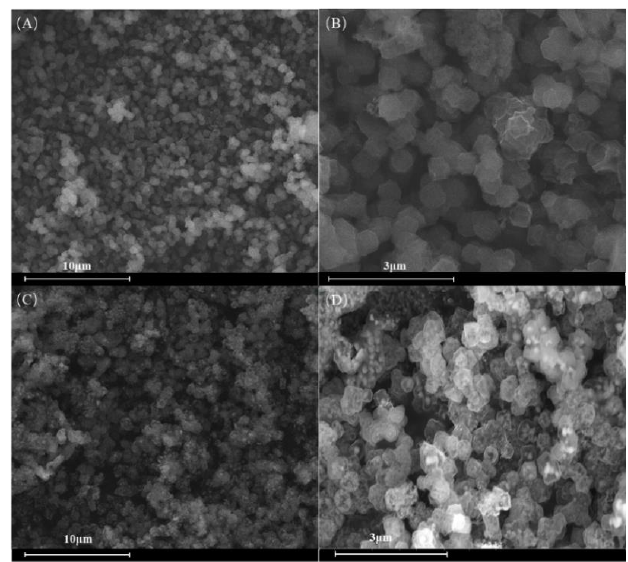
Figure 3. SEM images of: ( A,B ) ZnO/NC-600; ( C,D ) ZnCo/NC-600.